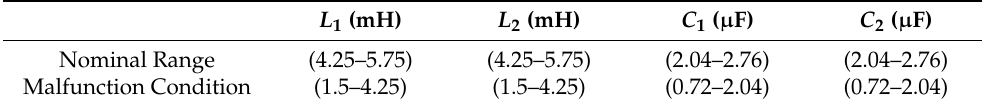
Table 3. Operating ranges.